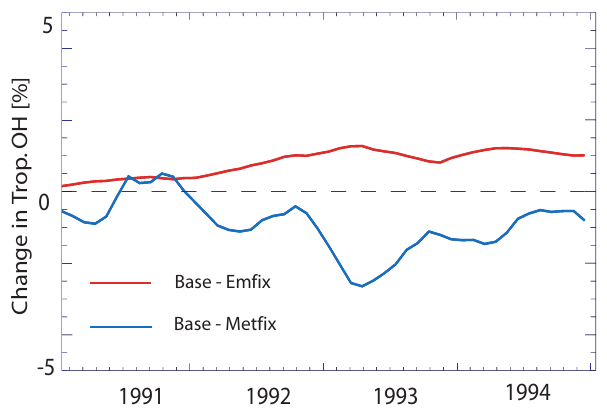
Fig. 4. Difference in tropospheric OH burden between Base and Emfix runs (red line) and Base and Metfix runs (blue line). A six month running mean is applied to show the long term trends.